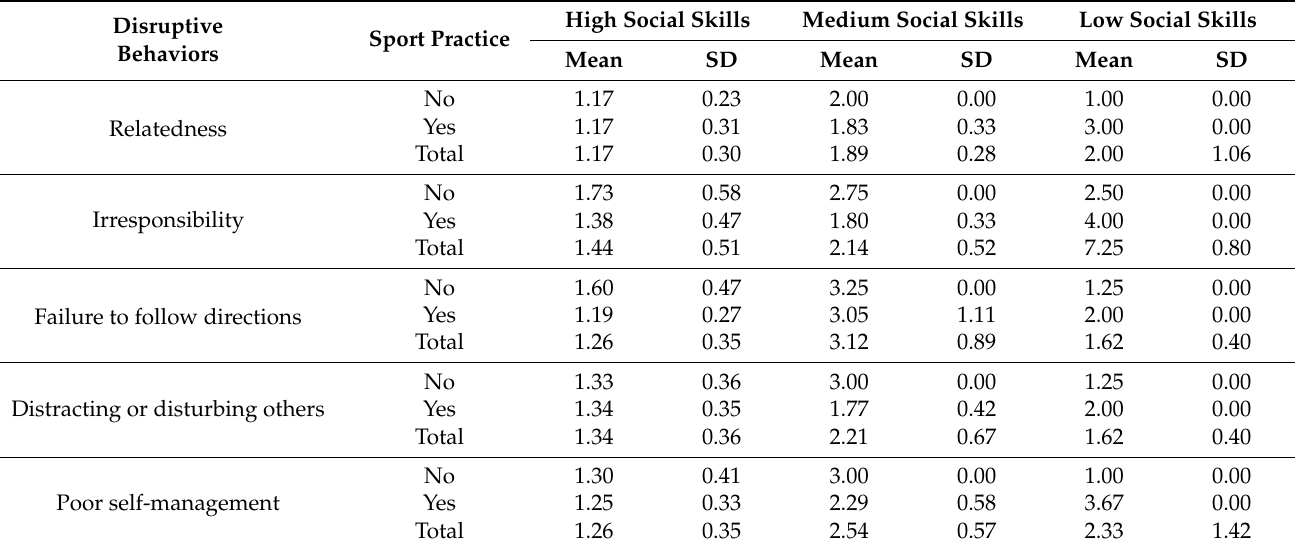
Table 2. Results of disruptive behaviors based on social skills and sport